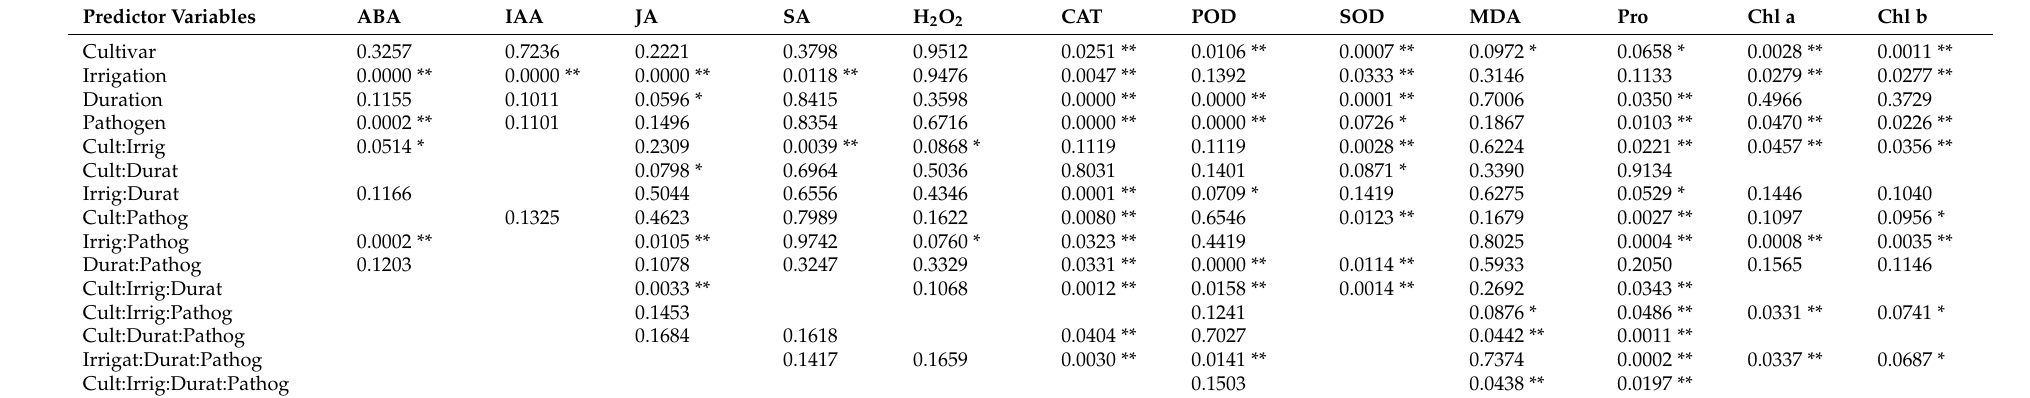
Table A1. p -values for the different factors and interactions retained in the models after model selection. Interaction terms that were not important for the models were removed based on the AIC. The linear regression analyzes the interactions between the predictor variables: cultivar (Chardonnay or Xynisteri), irrigation (full or deficit), duration (of the irrigation treatment; 9 or 16 dot) and pathogen ( P. viticola or water inoculation). Values are marked with a single asterisk if p -value <10% and with a double asterisk if p -value < 5%.